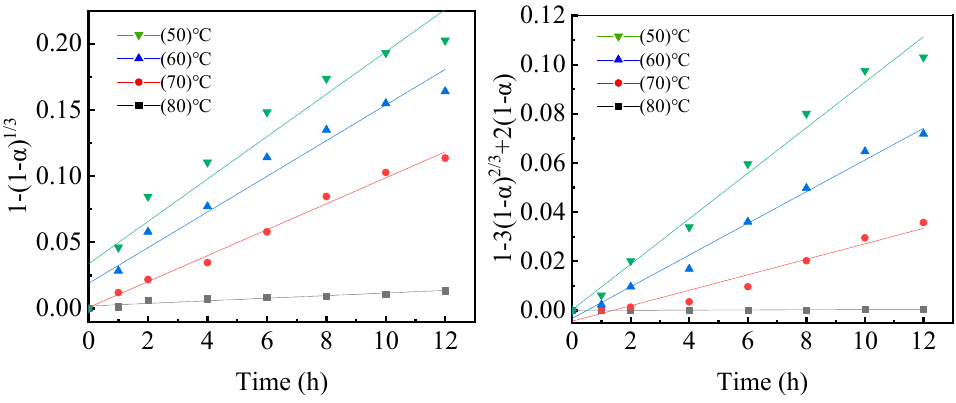
Figure 8. Kinetic model fitting curves of inactivated samples at different reaction temperatures.